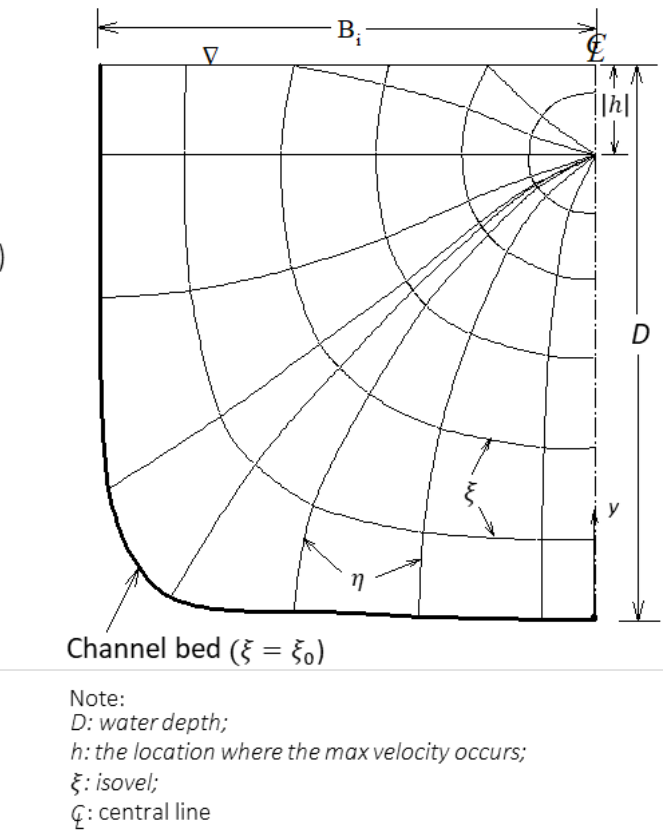
Figure 2. Velocity field in the 𝜂 − 𝜉 coordinate system with a set of isovels. ( a ) ℎ ≤ 0 ; ( b ) ℎ > 0 .